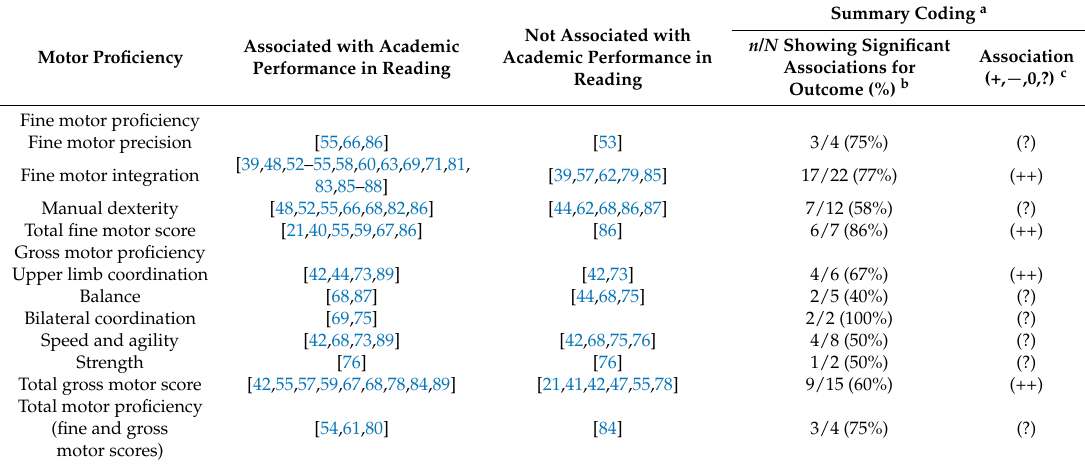
Table 2. Overall level of evidence from studies examining associations between specific components of motor proficiency and academic performance in reading in school-aged children and adolescents. Summary Coding a Not Associated with n / N Showing Significant Associated with Academic Academic Performance in Associations Performance in Reading Reading